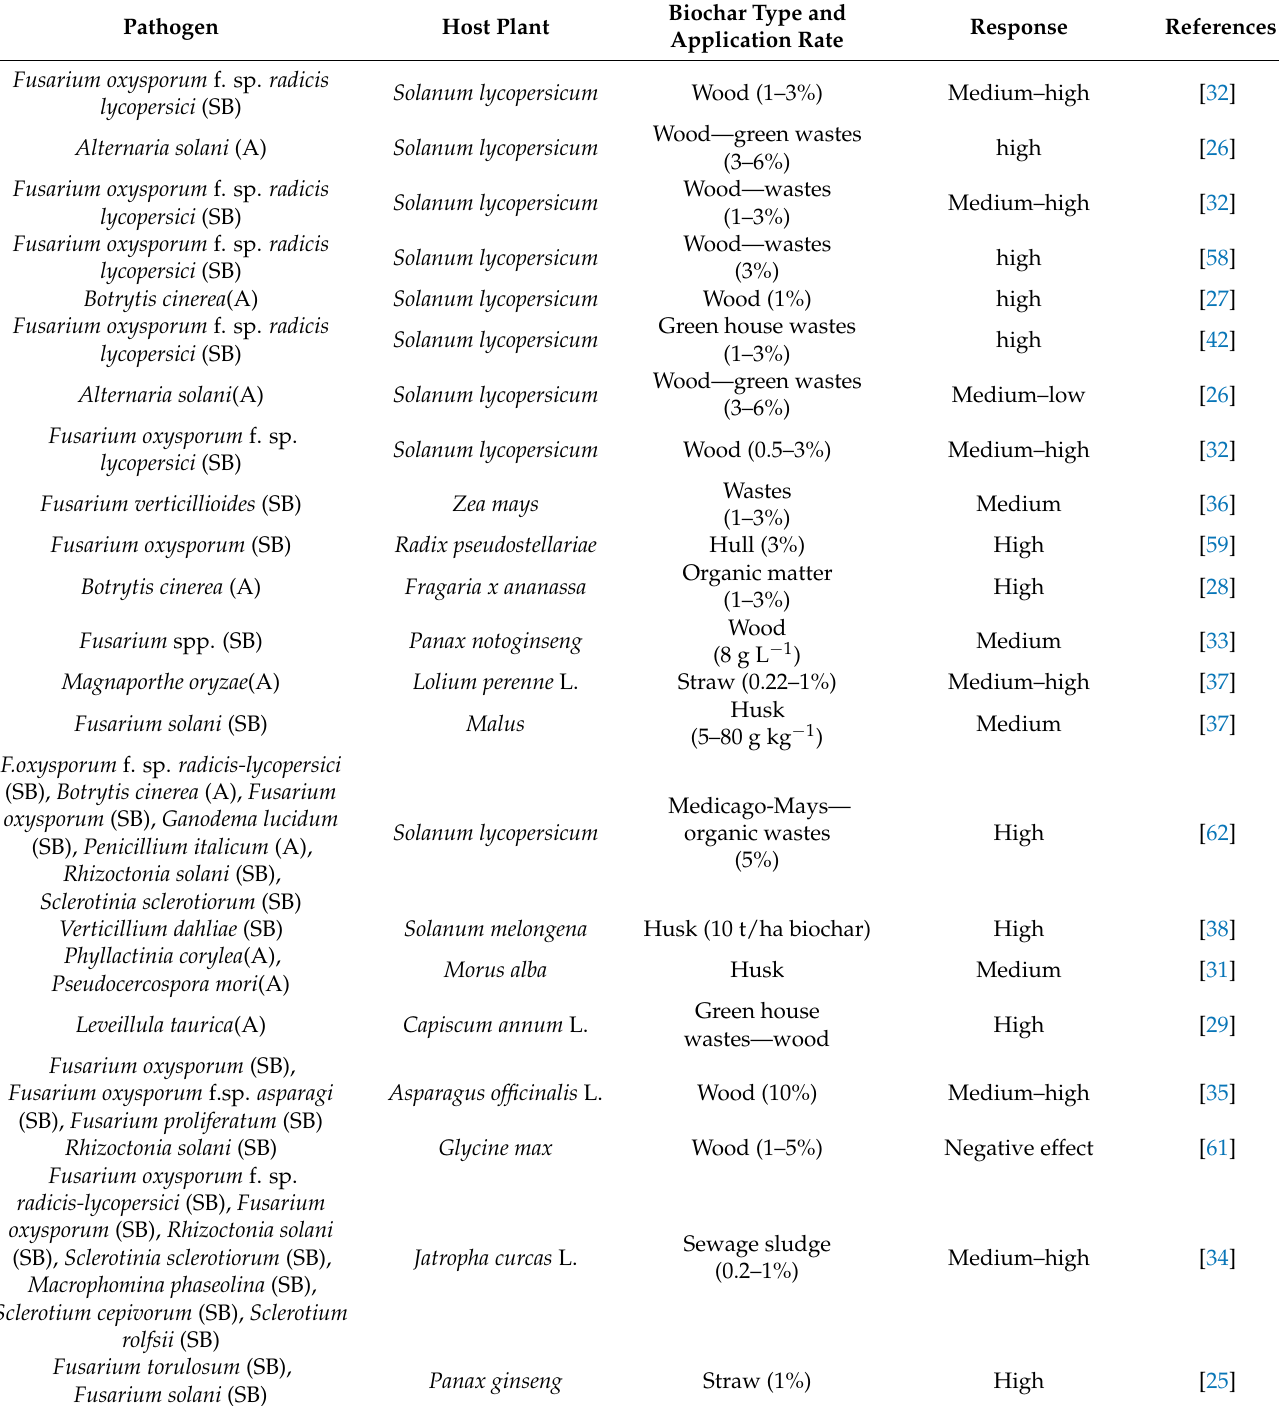
Table 2. List of experimental studies examples that applied biochar as a soil amendment to control plant diseases caused by airborne (A) and soilborne fungal (SB) pathogens. Pathogen, host plant, biochar feedstock type, response level, and reference are reported for each